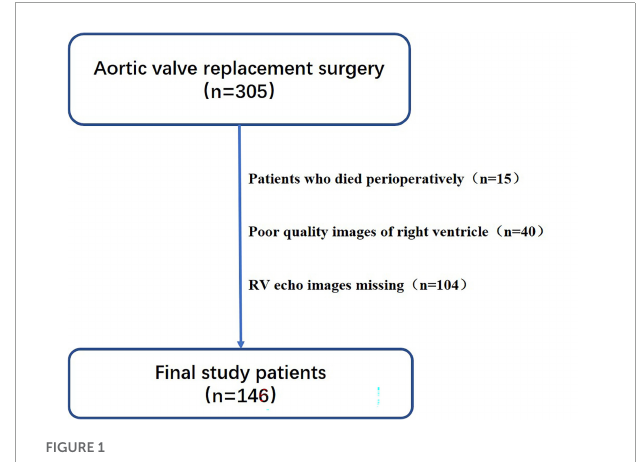
FIGURE1 Patient selection and study